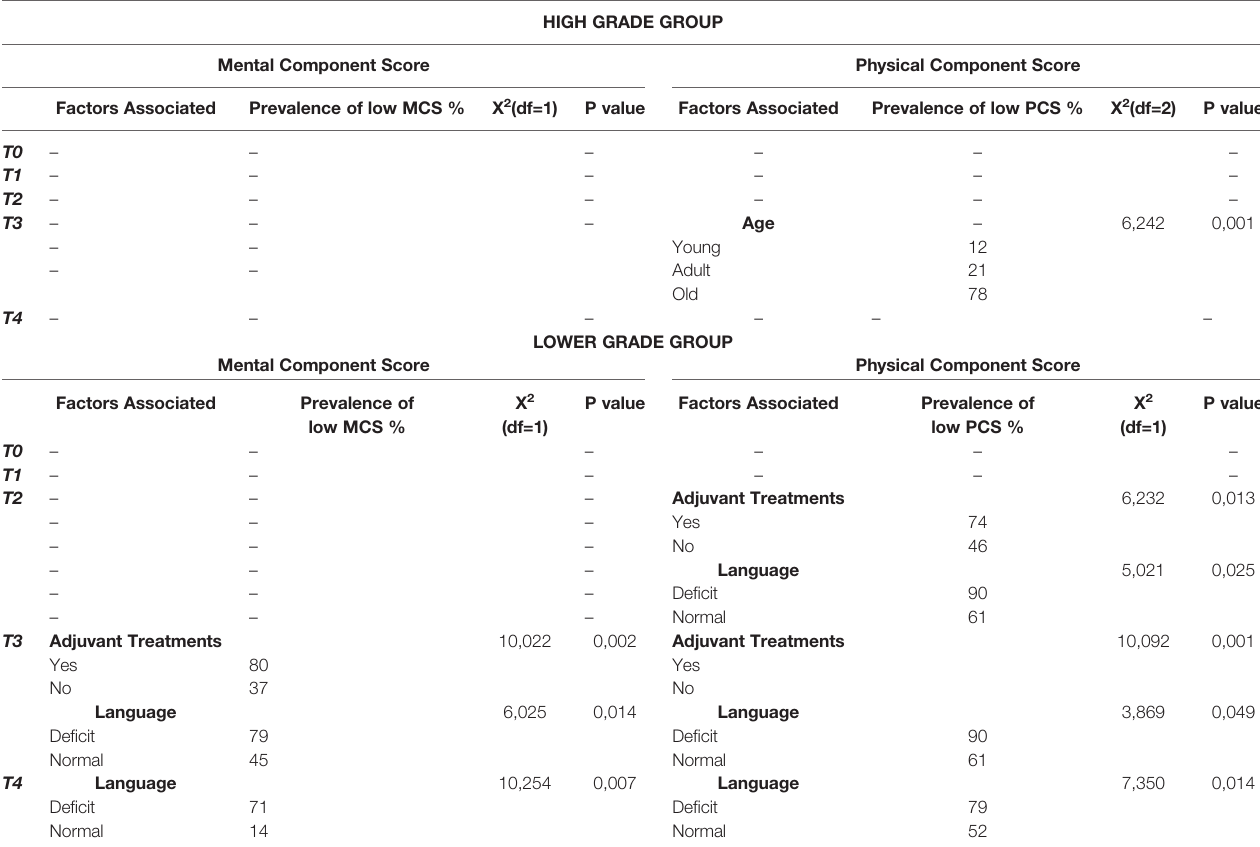
TABLE 4 | Factors Associated with low HRQoL in High and Lower grade glioma